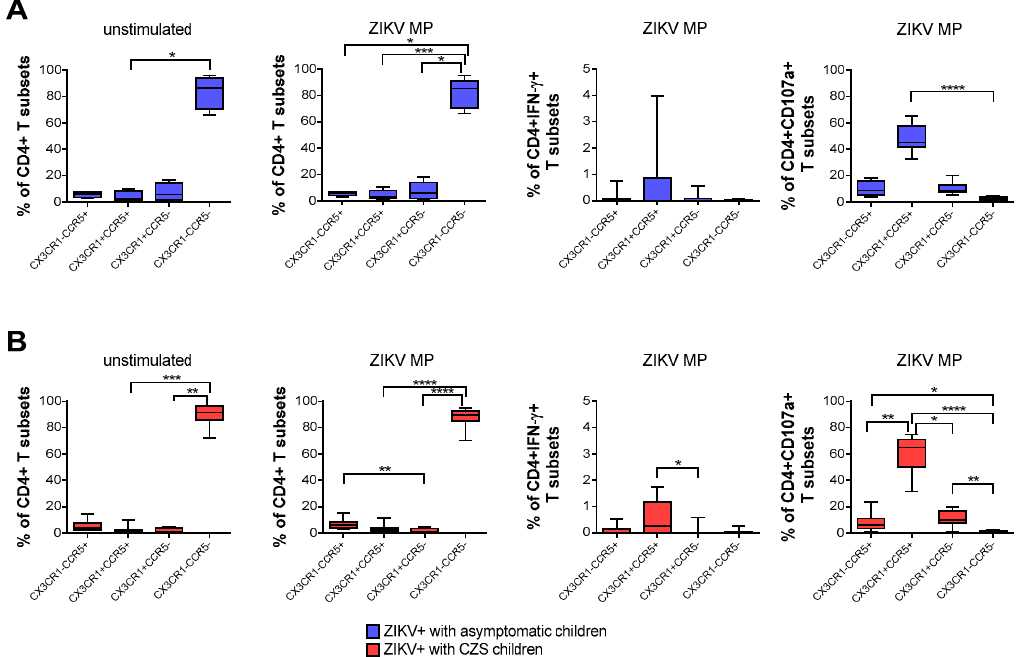
Figure 3. Expression of CCR5 and/or CX3CR1 correlated with the functionality of CD4 T cells from mothers with a history of ZIKV infection. Frequency of CD4+ T cells according to the expression of CCR5 and/or CX3CR1 in mothers who had asymptomatic babies (blue, n = 8–12) ( A ) and in those who had CZS children (red, n = 10) ( B ). Frequency observed after stimulation with ZIKV peptides in each group of mothers. The gates of IFN- γ -producing CD4+ T cells and CD4+CD107a+ were selected as an analysis strategy. Data are expressed as box and whiskers (min to max). Statistical analyses were performed using Friedman’s test followed by Dunn’s multiple comparisons test between the groups of mothers. Asterisks indicate significant differences (* p < 0.05, ** p < 0.01, *** p < 0.001, **** p < 0.0001).